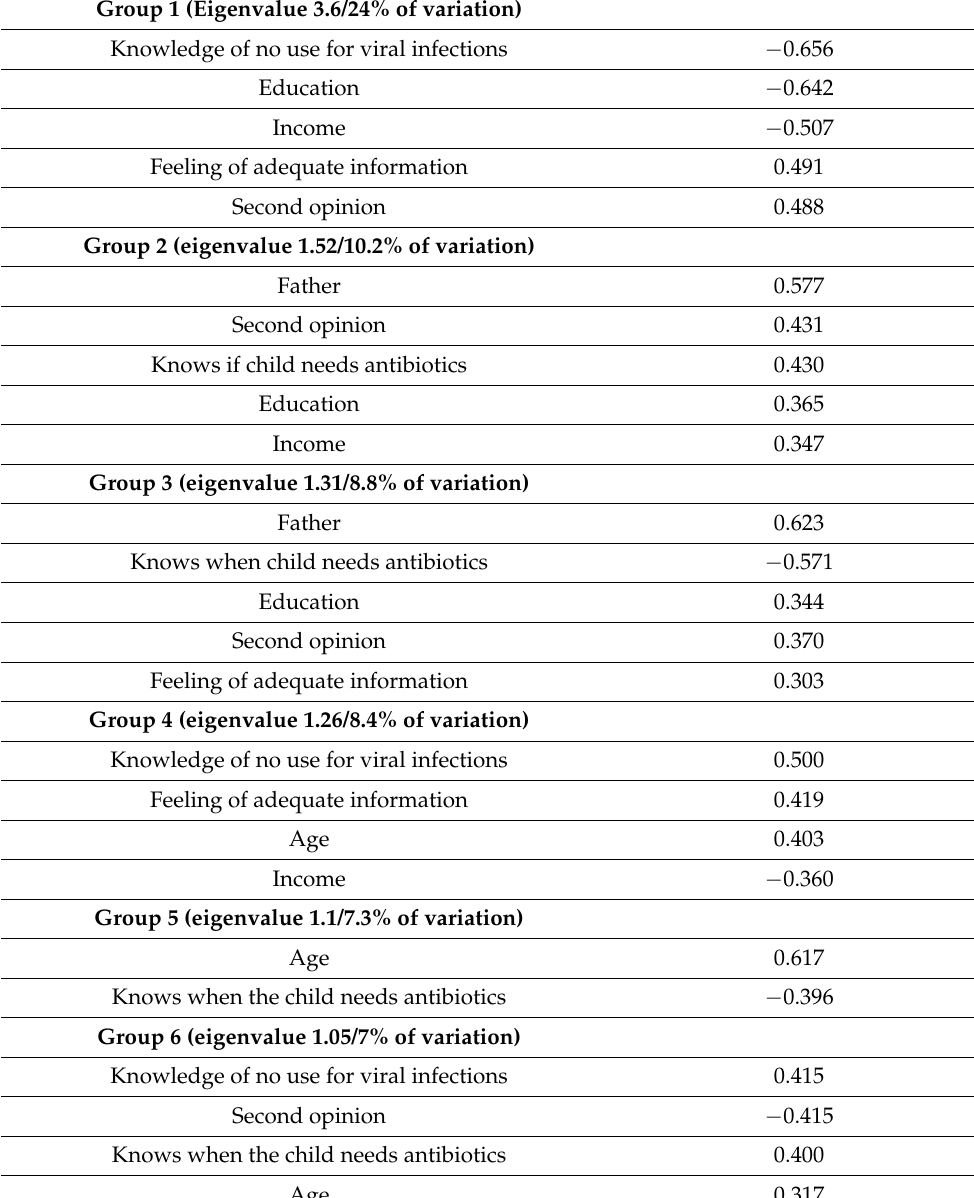
Table 3. Factor analysis of parental characteristics associated with antibiotic misuse